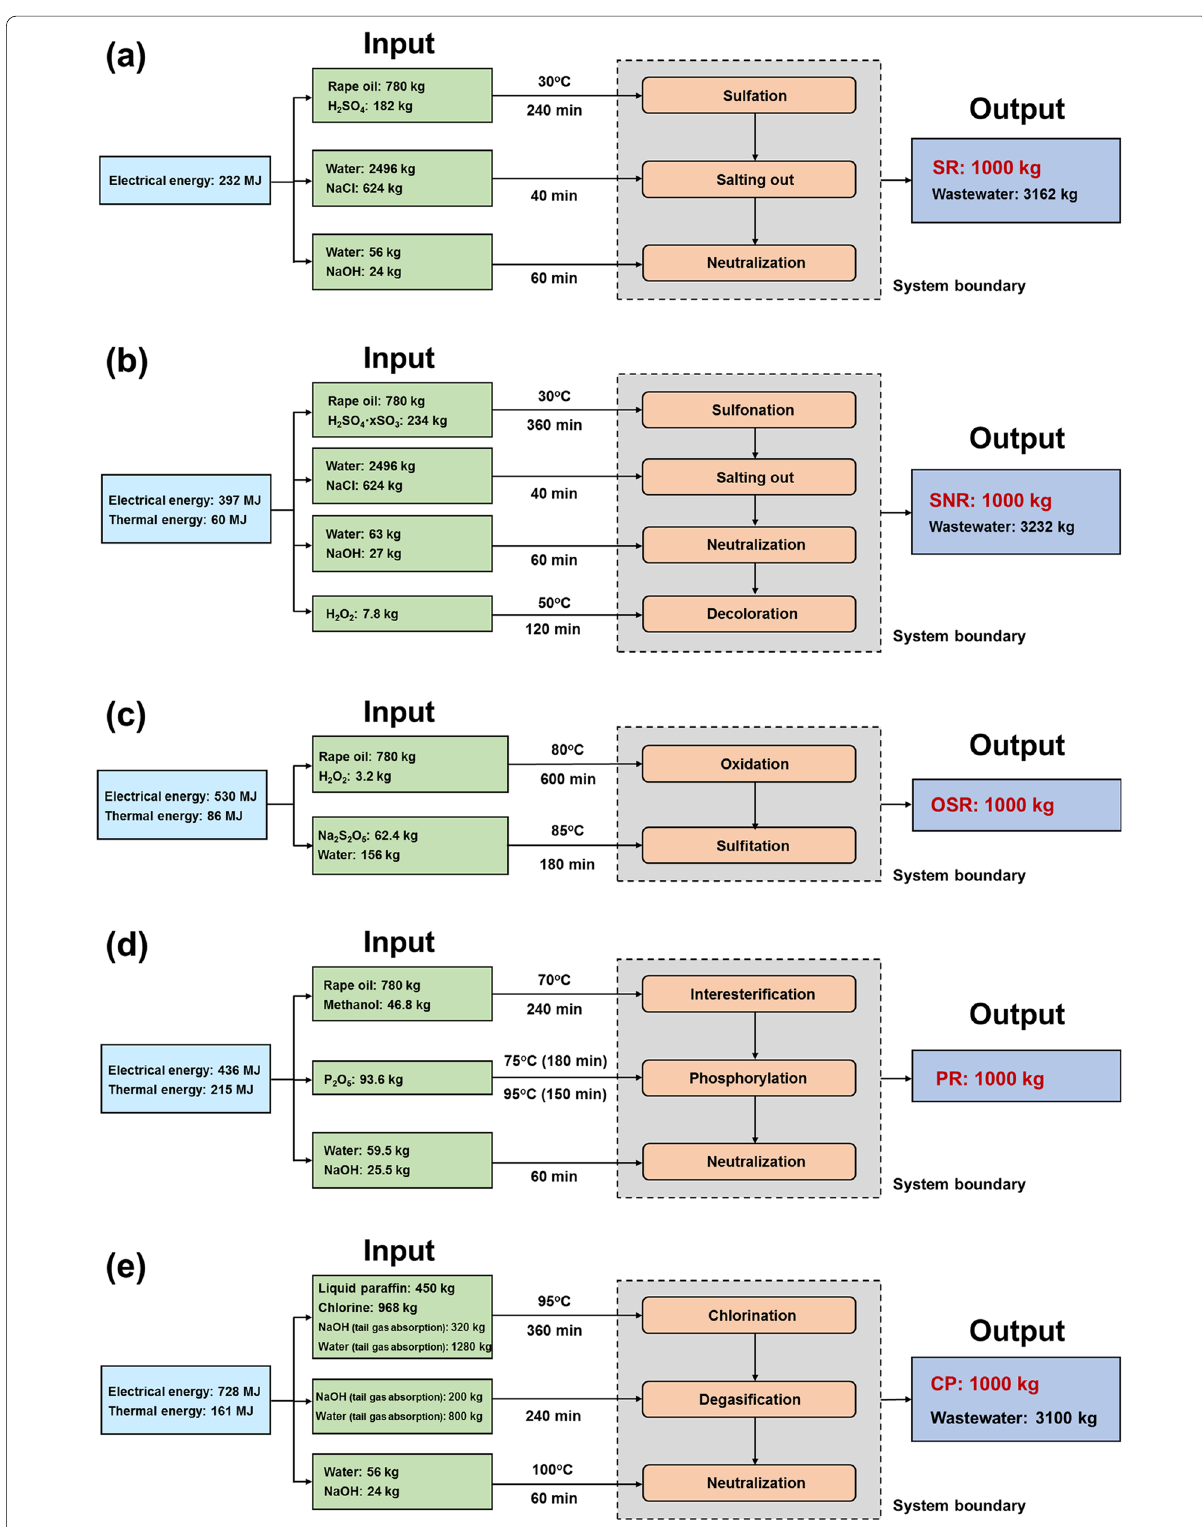
Fig. 2 Energy, chemical, and effluent inventories for SR ( a ), SNR ( b ), OSR ( c ), PR ( d ), and CP ( e )